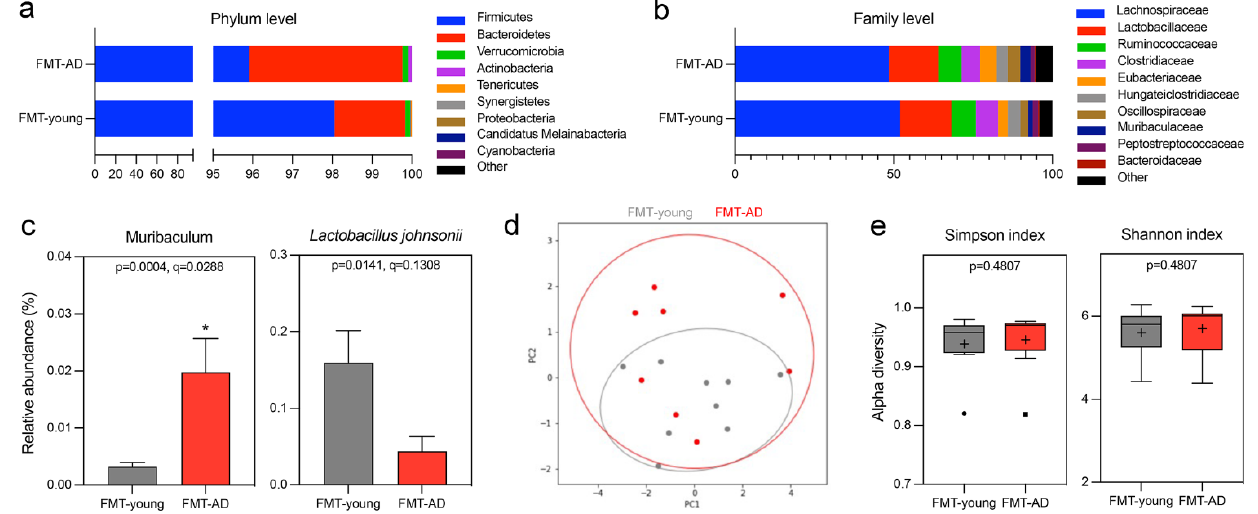
Figure 2. Gut microbiome changes after FMT from aged AD mice. ( a , b ) Relative abundances of the top 9 phyla ( a ) and families ( b ) in the cecum microbiota of mice that received FMT from young WT (FMT-young) or aged AD (FMT-AD) mice. ( c ) Relative abundances of the genera and species show significant alterations in the random-effects multivariate analysis for FMT-young ( n = 9, gray) and FMT-AD ( n = 8, red). An abundance cutoff of >0.1% was applied at the species level. * q < 0.05. ( d ) Principal Coordinate Analysis (PCoA) ordination plot based on Weighted UniFrac distances for FMT-young ( n = 9, gray) and FMT-AD ( n = 8, red). The confidence ellipses represent the 95% confidence interval. Analysis of Similarity (ANOSIM) evaluated group dissimilarities. ( e ) Shannon and Simpson alpha diversity indices at the species level for FMT-young ( n = 9, gray) and FMT-AD ( n = 8, red). In the box and whisker plots, the cross represents the mean. Significance was determined by Kruskal–Wallis, followed by Dunn’s multiple comparisons test.